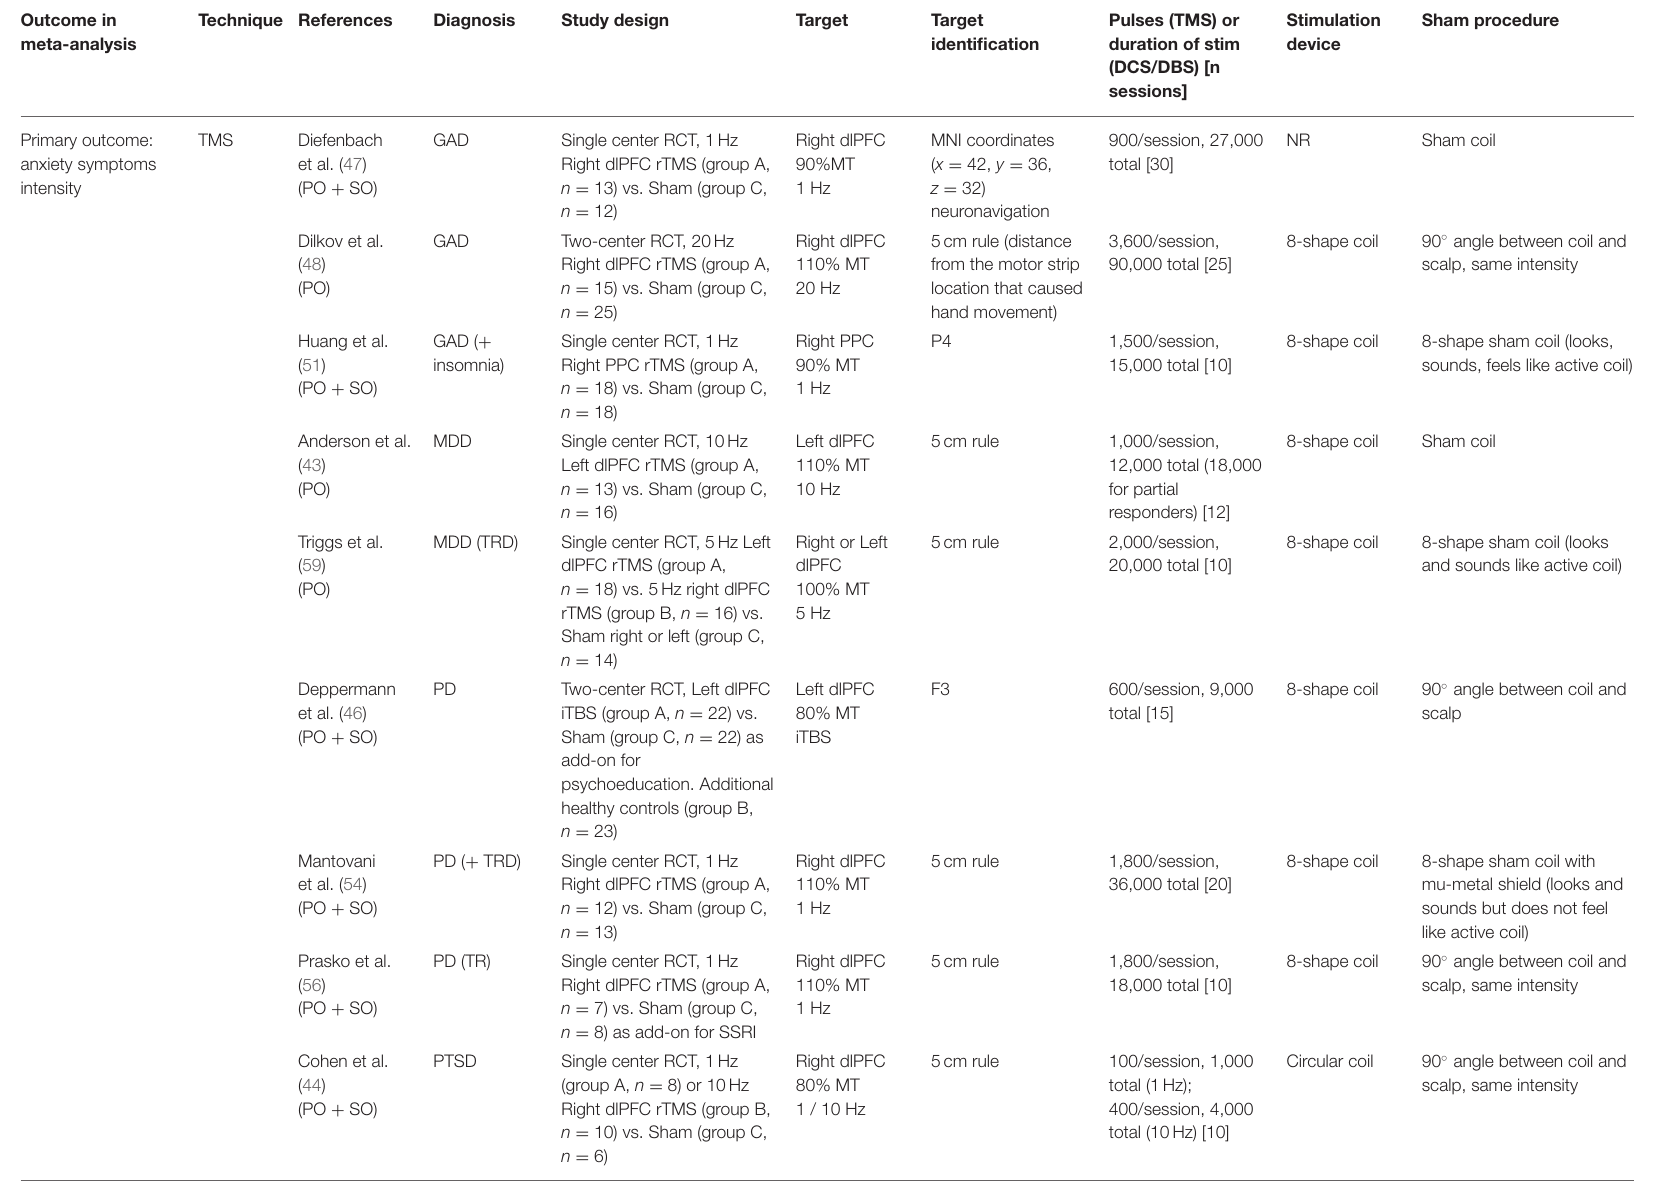
TABLE 1 | Characteristics of included studies (diagnosis, study design, target, stimulation and sham